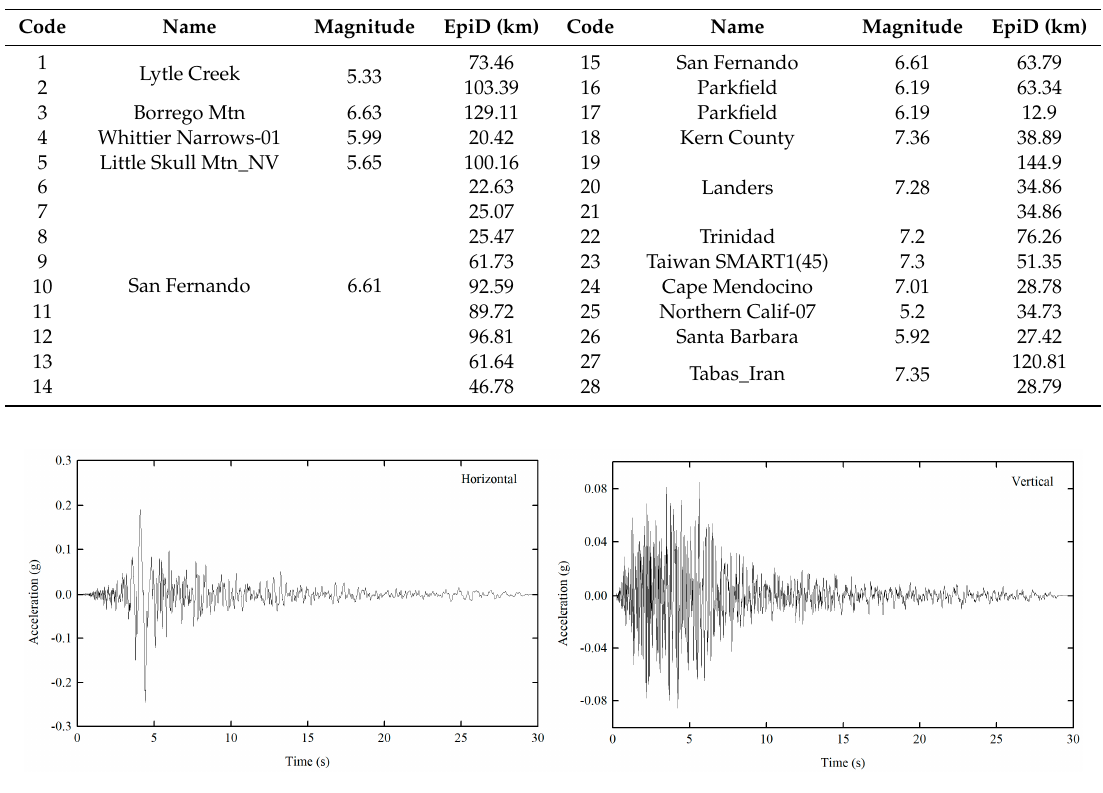
Figure 2. Acceleration time-histories curves of the Whittier Narrows-01 wave.